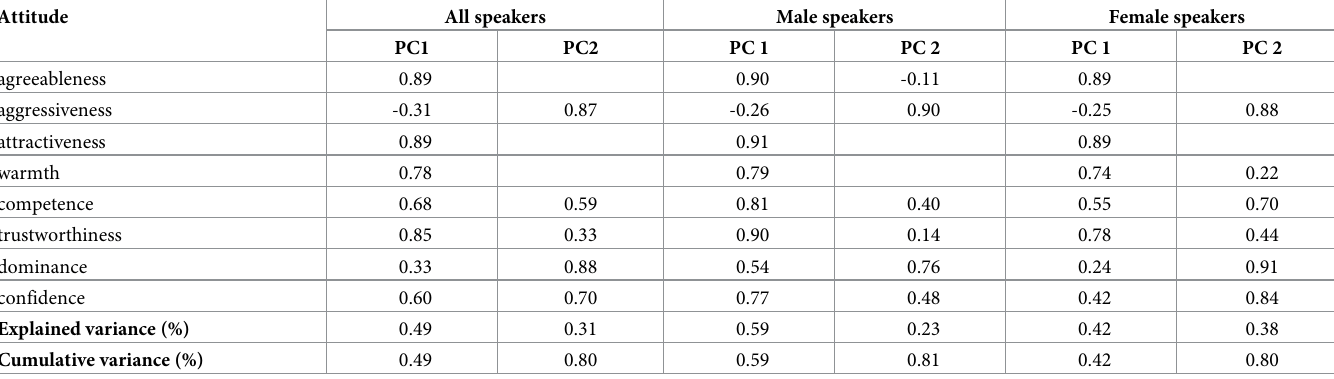
Table 1. Weighted linear combinations of attitudinal traits shows individual contribution of all attitudes on the first and second principal components (PC) for all speakers, male speakers and female speakers, after PCA with Varimax rotation. Attitude All